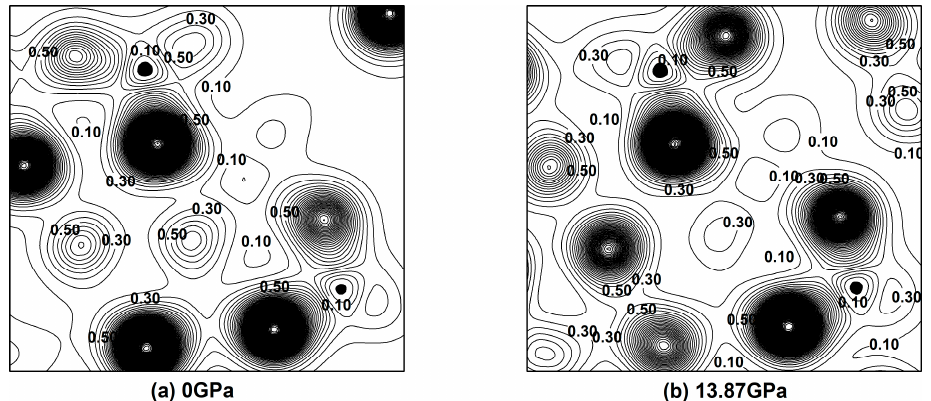
Figure 7. The charge density distribution of the Al-O-Si plane in pyrophyllite [Al 4 Si 8 O 20 (OH) 4 ]. ( a ) The charge density distribution of the Al-O-Si plane at 0 GPa; ( b ) The charge density distribution of the Al-O-Si plane at 13.87 GPa.